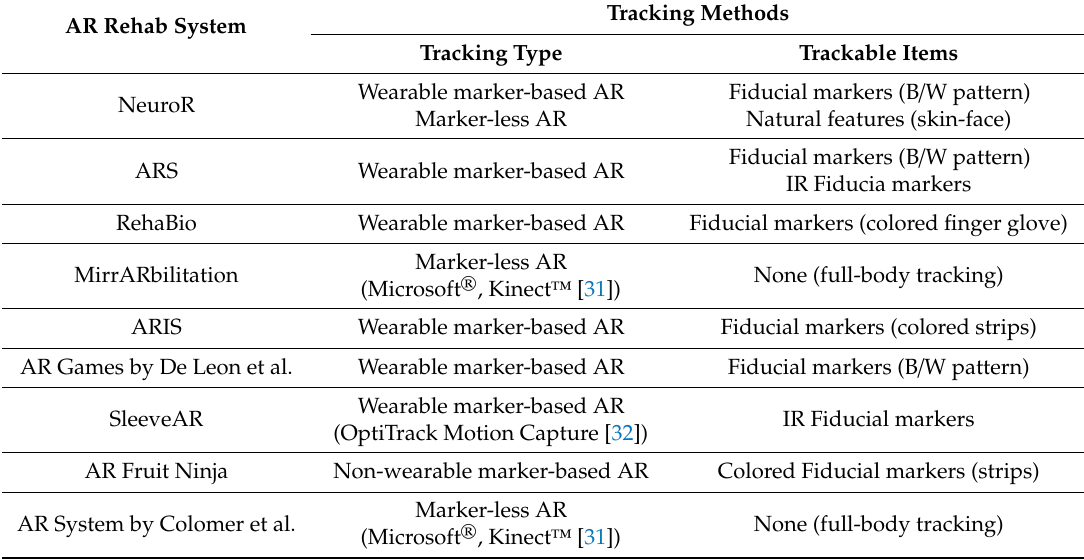
Table 2. Tracking methods utilized by the AR Rehab Systems